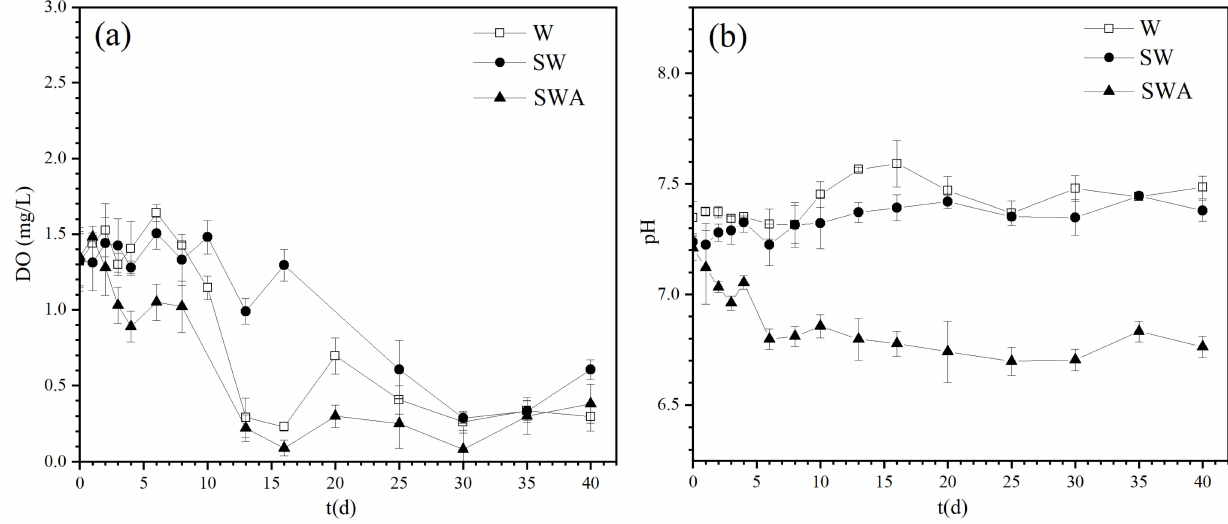
Figure 3. Changes in DO and pH during the black blooms process: ( a ) DO; ( b ) pH. (W: water; SW: sediments-water; SWA: